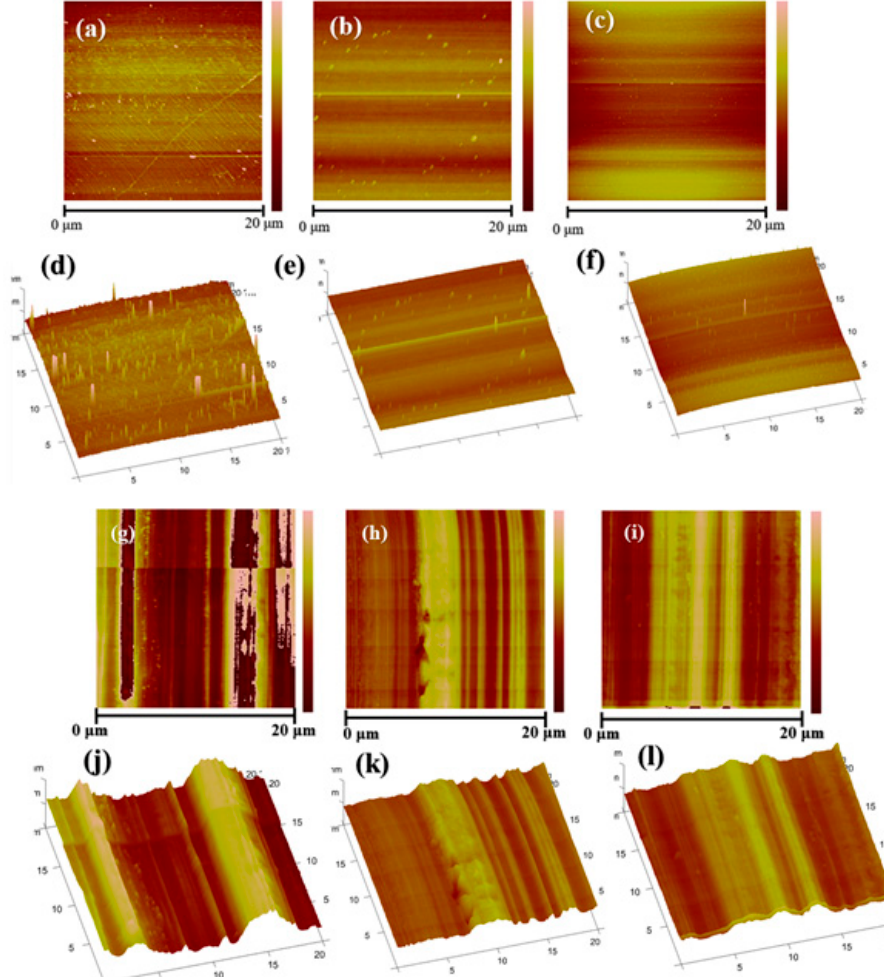
Figure 4. The AFM of ( a ) and ( d ) graphene grown on pristine copper foil; ( b ) and ( e ) graphene grown on copper foil pre-treated by AP; ( c ) and ( f ) graphene grown on copper foil pre-treated by AA; ( g ) and ( j ) pristine copper foil; ( h ) and ( k ) copper foil pre-treated by AP; ( i ) and ( l ) copper foil pre-treated by AA.